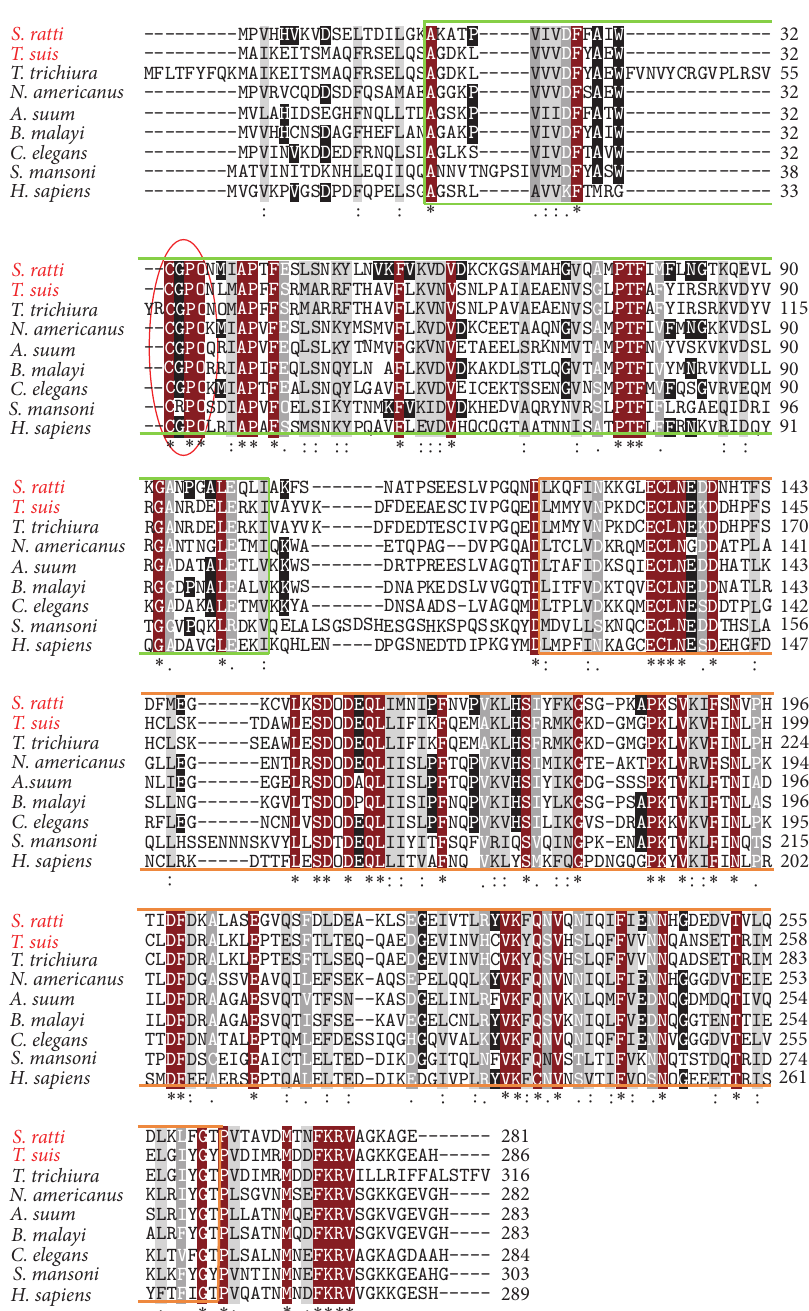
Figure 1: Multiple alignment of the Trx-lps from different organisms. S. ratti (CEF66761.1); T. suis (KHJ44020.1); T. trichiura (CDW52389.1); Necator americanus (XP 013304103.1); Ascaris suum (ERG80831.1); Brugia malayi (XP 001892562.1); C. elegans (NP 491127.1); Schistosoma mansoni (CD80891.1); H. sapiens (NP 004777.1). Green box represents the Trx-like domain; orange box represents the PITH domain; red circle shows the active